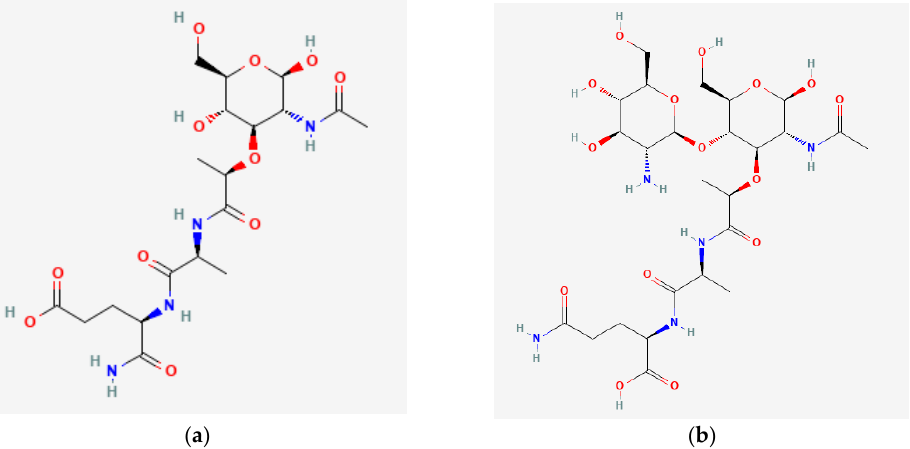
Figure 1. ( a ) N-Acetylmuramyl-L-Alanyl-D-Isoglutamine (MDP); ( b ) N-Acetyl-D-Glucosaminyl-(beta1,4)-N Acetylmuramyl-L-Alanyl-D-Isoglutamine (GMDP). The presence or absence of muramyl peptides (MPs) in the organism of a healthy person was a long time of discussion. Methods of mass chromatography (MC), gas liquid chromatography (GLC), and mass spectrometry (MS) were used to determine MPs in human tissues and fluids in order to identify the relationship with chronic infectious foci